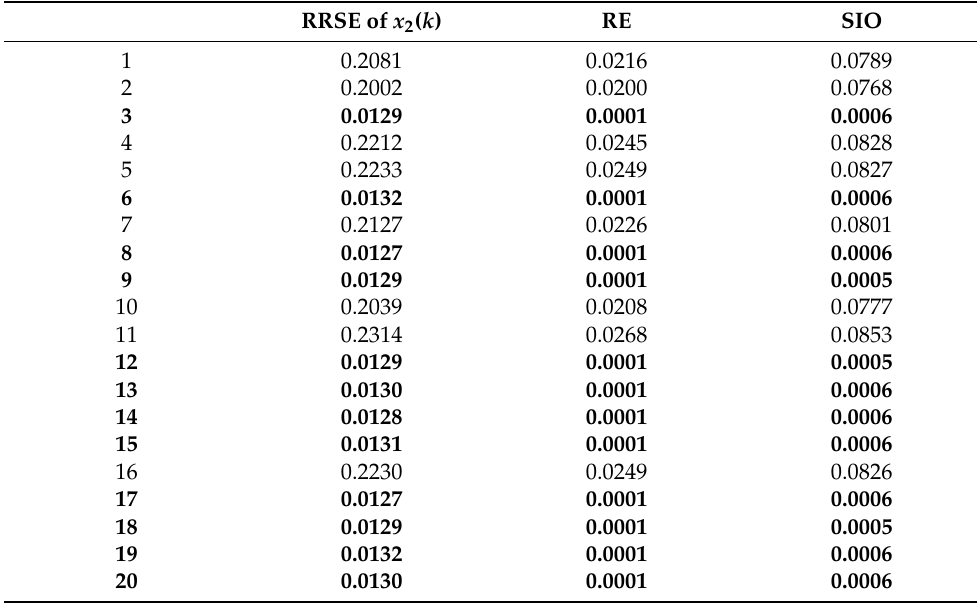
Table 3. Decomposing results of ICEEMDAN (SFR = 21.7, AR =